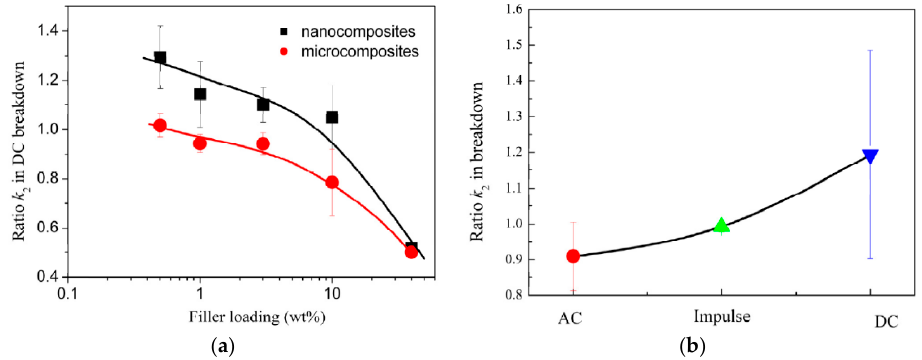
Figure 34. Ratio k 2 ( a ) in DC electrical breakdown versus micro/nanofillers concentration and ( b ) of nanocomposites in electrical breakdown depending on the AC and DC applied voltage (© 2016 IEEE. Reprinted, with permission, from